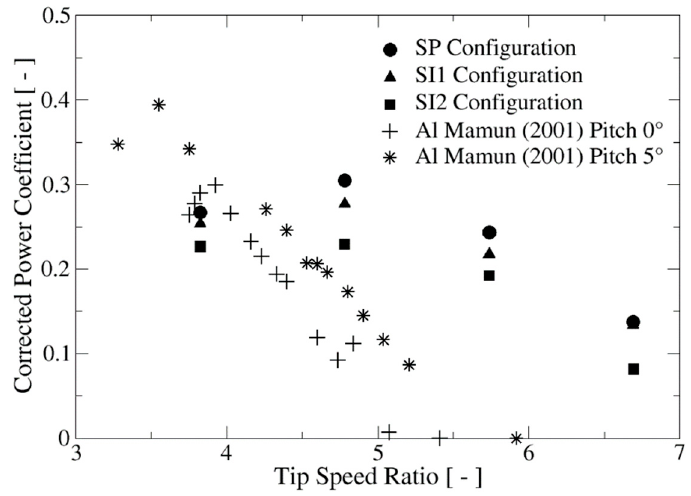
Figure 19. The comparison of the CFD computation of the present study versus the experimental measurements of Reference [19] in a 45° inclined rotor with the incident flow velocity of 0.65